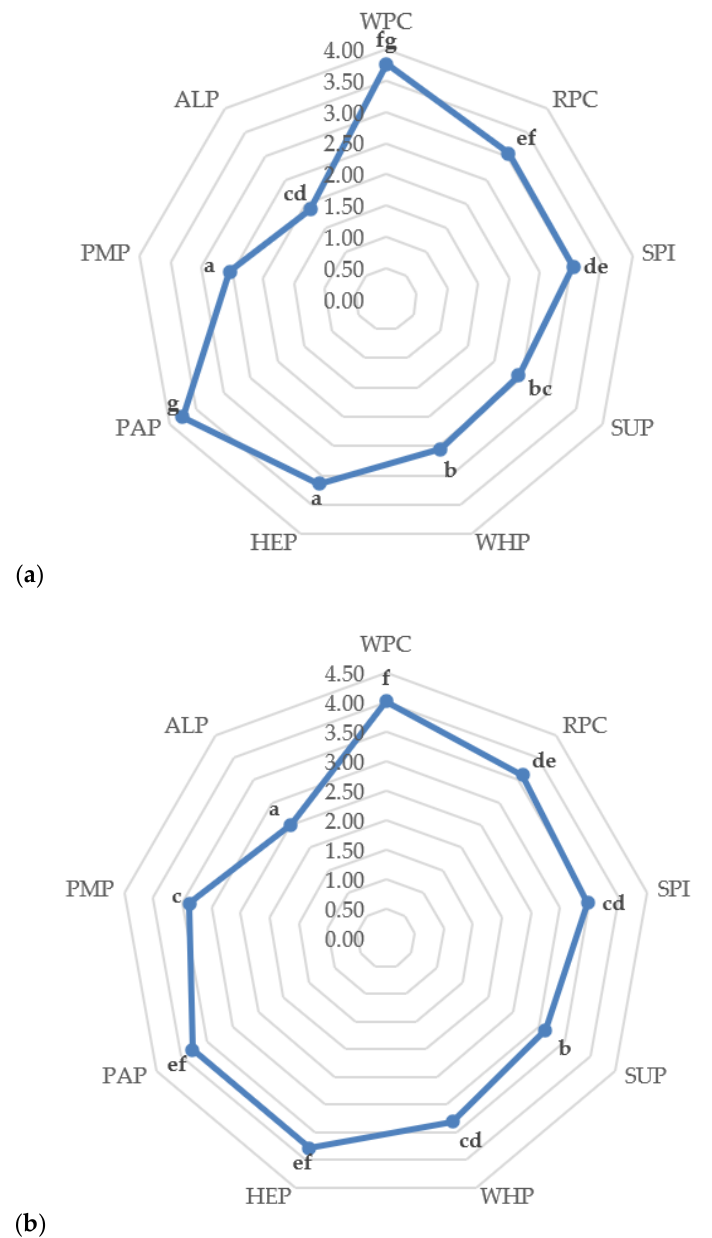
Figure 8. ( a ) Sensory evaluation of high-protein bars without chocolate coating; ( b ) With chocolate coating. a–g Means in the same column with different superscripts are significantly different ( p < 0.05, Tukey’s HSD test).